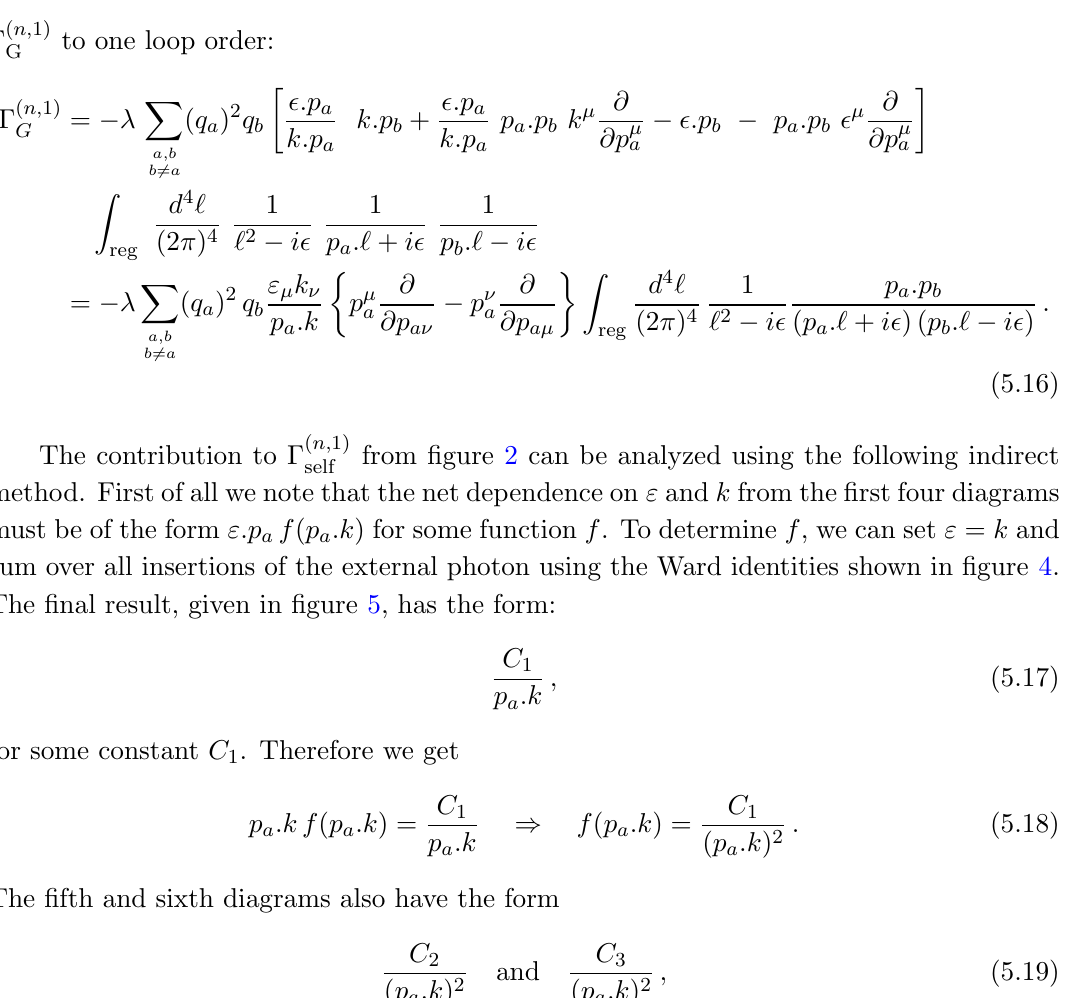
Figure 5 . Sum of the (cid:12)rst four diagrams in (cid:12)gure 2 with " replaced by k